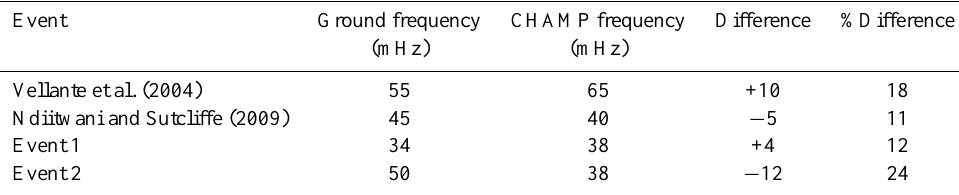
Table 1. Comparison of the FLR Doppler shifts of previous and current events. Event Ground frequency CHAMP frequency Difference %Difference (mHz) (mHz) Vellante et al. (2004) 55 65 +10 18 Ndiitwani and Sutcliffe (2009) 45 Event 1